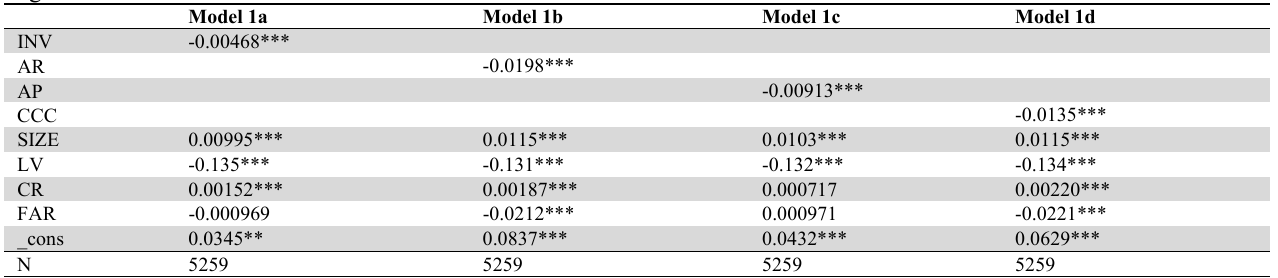
Regression results of Model 1 Model 1a